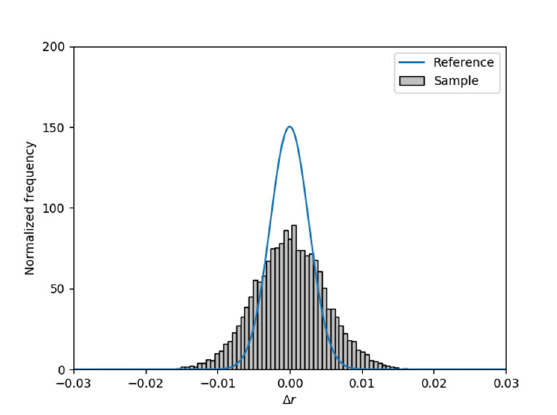
Fig. 4. Histogram of 𝛥𝑟 (when 𝐕(cid:3553) 𝐦 (cid:3404) 0.1 (cid:2870) 𝐕 𝐦 )